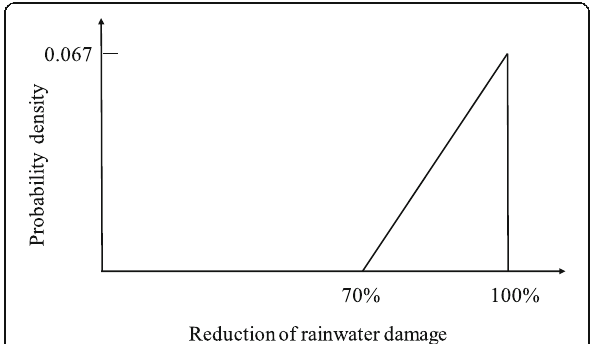
Fig. 10 Reduction of rainwater damage to internal linings by using water-resistant